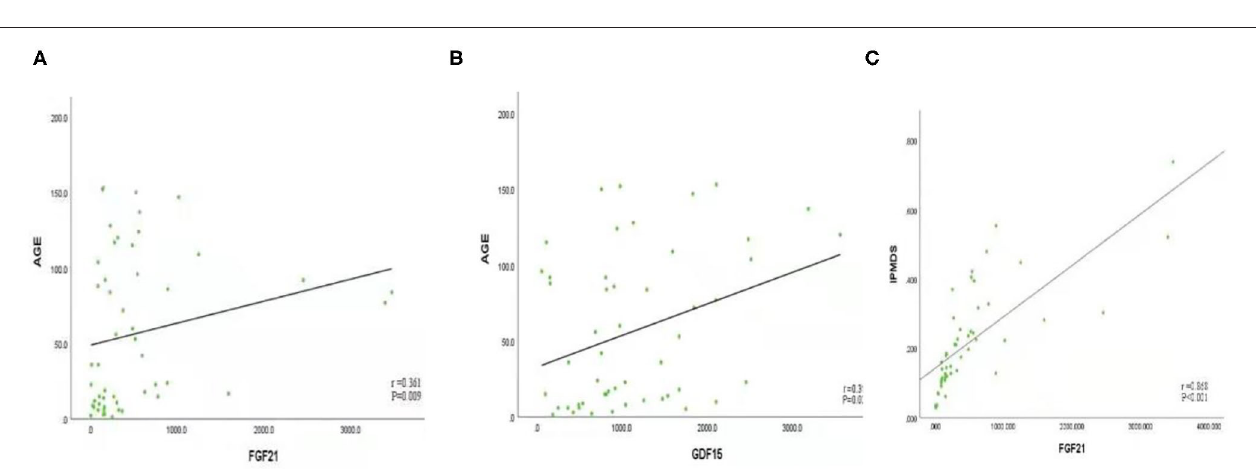
FIGURE 3 | (A) FGF21 is positively correlated with age ( r = 0.361, P < 0.05). (B) GDF15 is positively correlated with age ( r = 0.318, P < 0.05); (C) FGF21 was positively correlated with International Paediatric Mitochondrial Disease Scale (IPMDS) score ( r = 0.586, P <